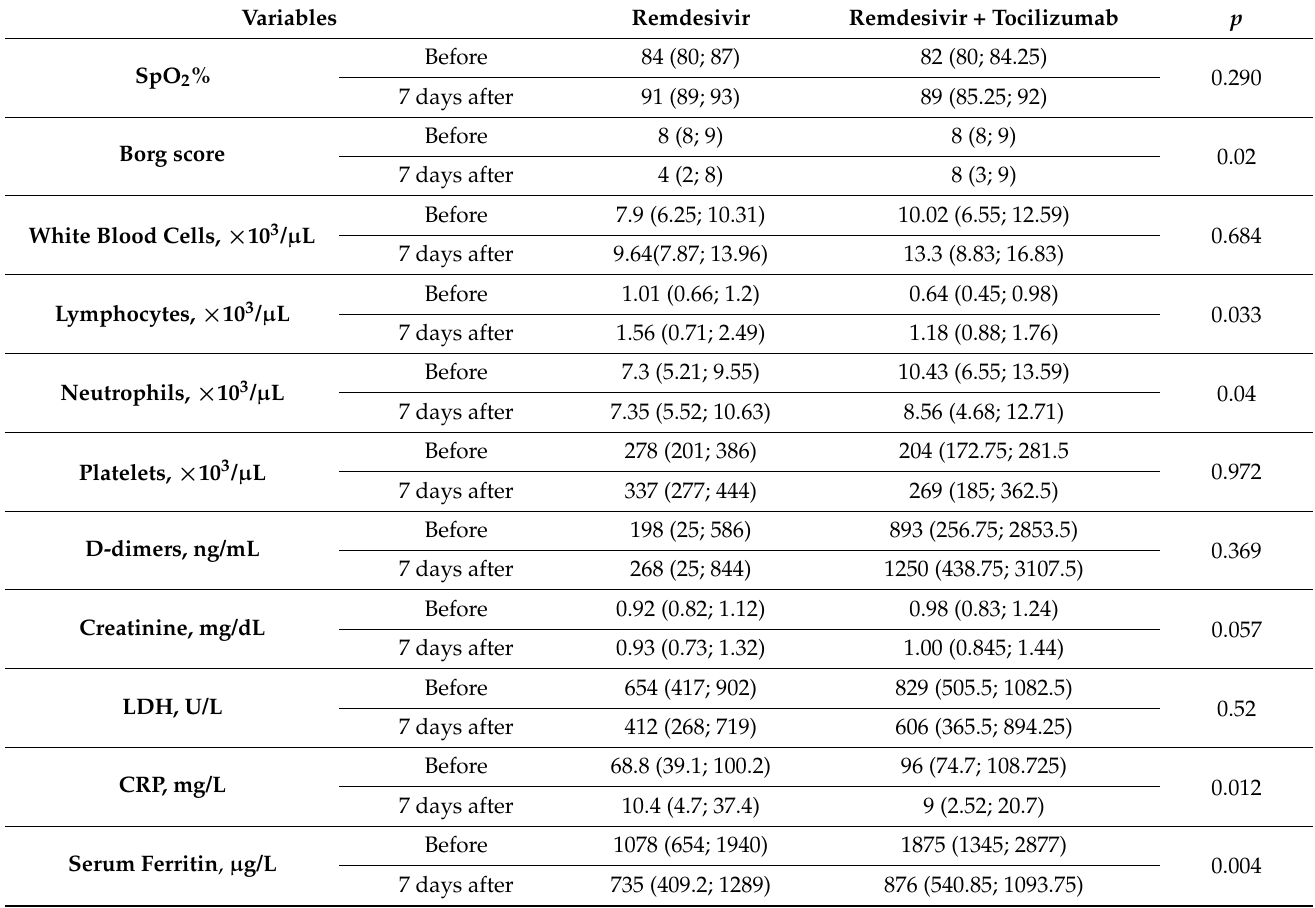
Table 2. Clinical and laboratory characteristics, measured before treatment and after 7